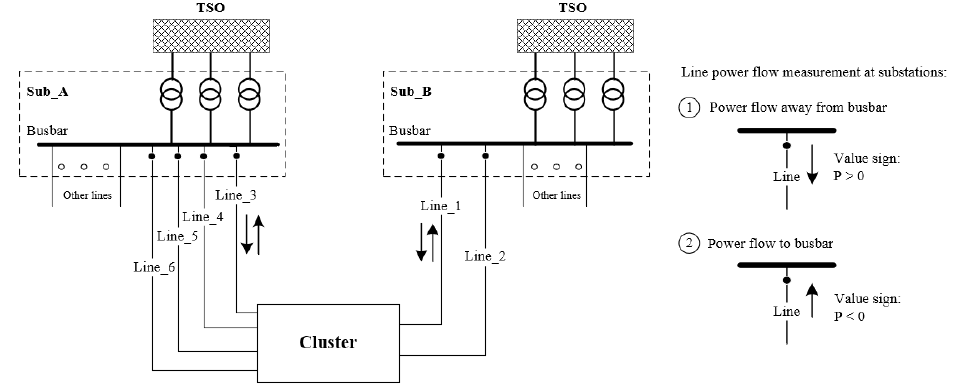
Figure 6. Investigated network cluster.